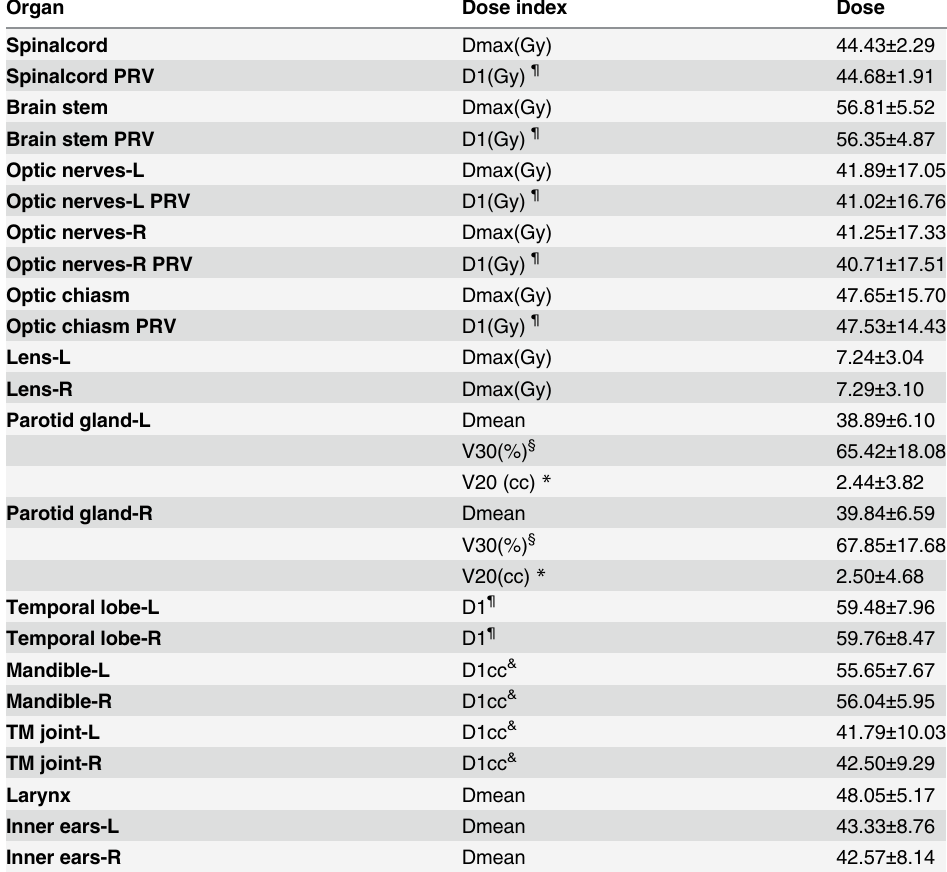
Table 3. Mean ( ± SD) of the doses for organs at risk for the 205 patients treated with volume-modu- lated arc therapy. Organ Dose index Dose